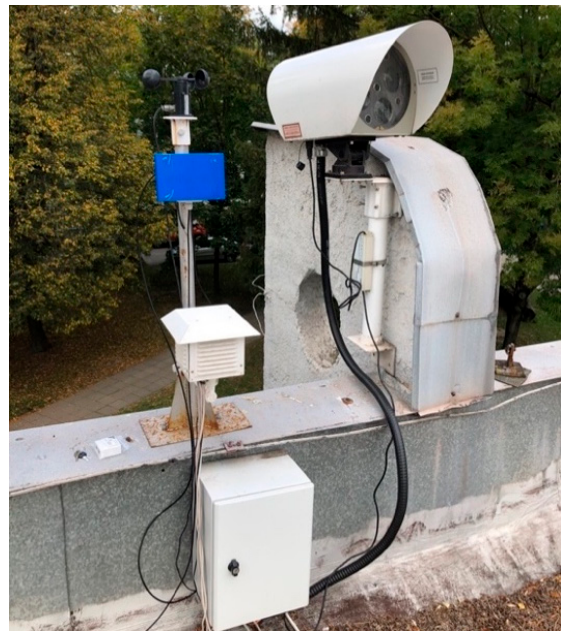
Figure 1. Scheme of the hybrid free space optics (FSO)/ radio-frequency (RF) system.